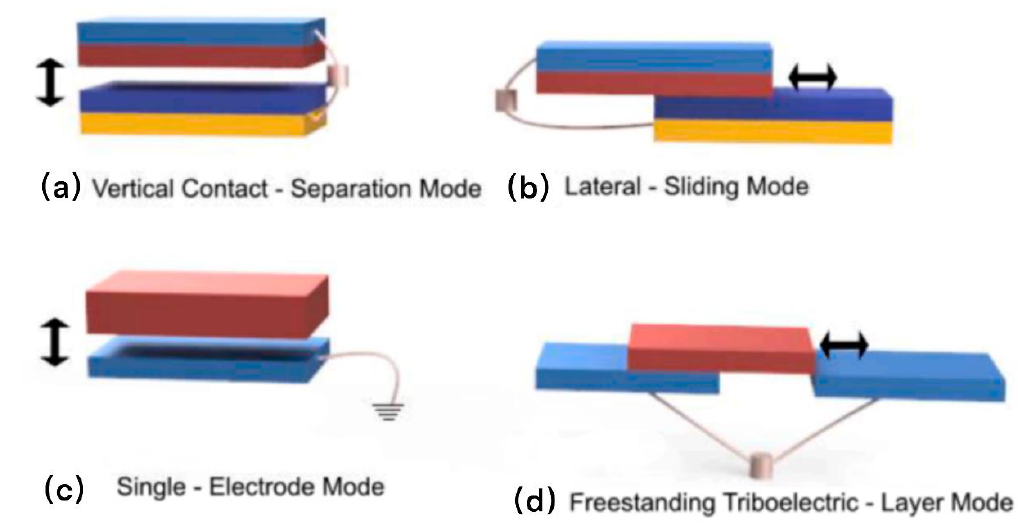
Figure 2. ( a – d ) Four working principles of the TENG [29] (Ryan et al. (2021),